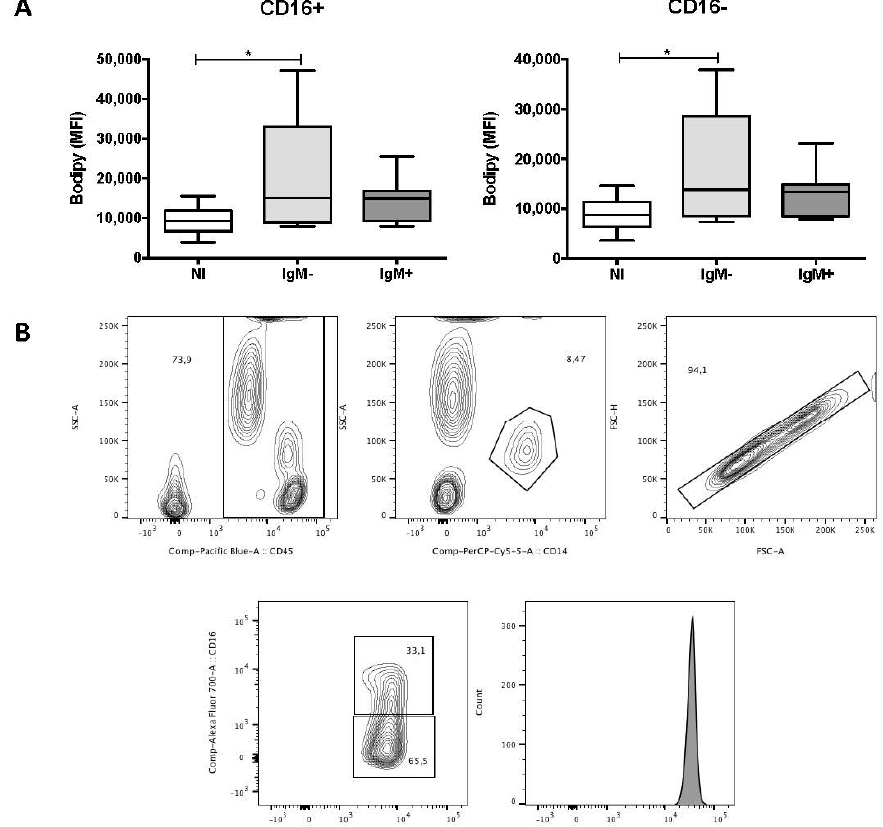
we measured the median fluorescence intensity (MFI) of Bodipy 493/503, a green fluorescent dye that binds to the neutral lipids in LBs. Figure 2A shows that the MFI of Bodipy 493/503 in CD16 + (15,007 versus 9238) and CD16 − (13,824 versus 8806) monocytes from the IgM-negative group was higher compared with the non-infected group ( p < 0.05). In contrast, there was no difference in the MFI of Bodipy 493/503 when comparing subpopulations of monocytes from the non-infected and IgM-negative groups. The gating strategy used to analyze the monocytes is demonstrated in Figure 2B. DENV infection did not alter the MFI of Bodipy 493/503 in neutrophils, eosinophils, lymphocytes, NK and NK T cells [26].